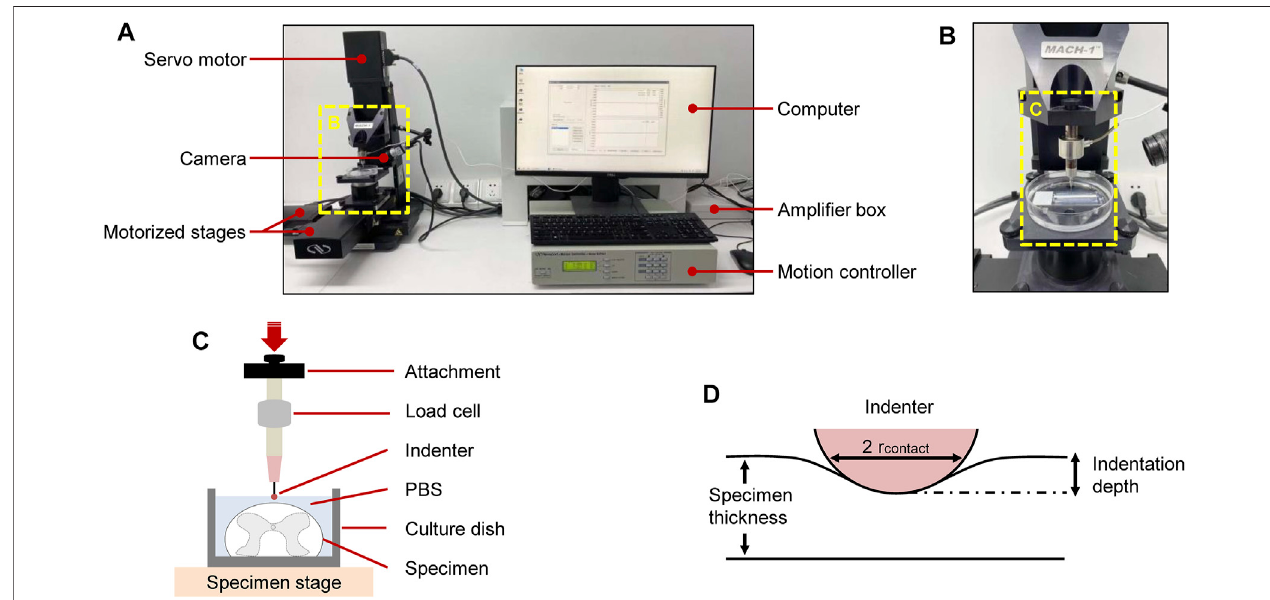
FIGURE 1 | Experimental setup for ex vivo SCPC tissue indentation testing. Test apparatus showed indentation testing rig and assistive devices (A) . Mechanical indentation was conducted by a Mach-1 Model V500css test device (B) . Schematic of indentation testing setup (C) . Schematic of indentation process (D) .